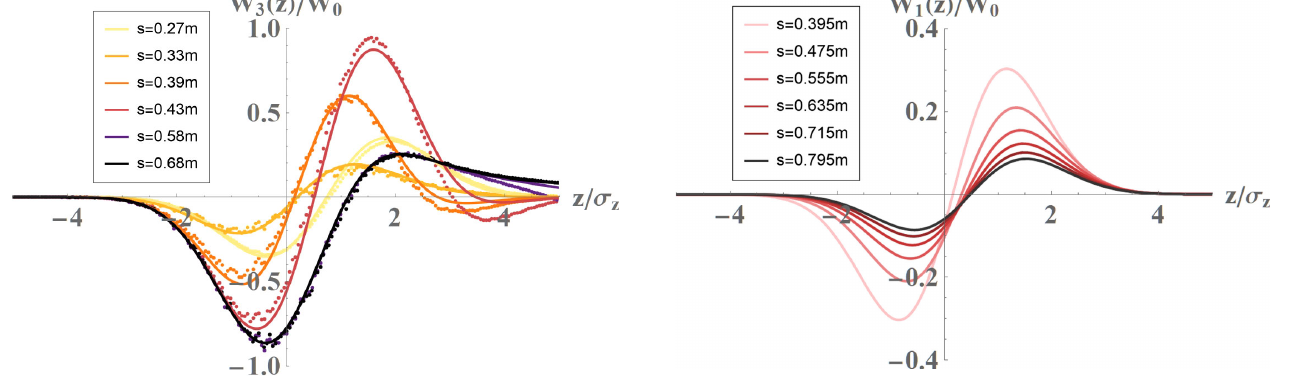
FIG. 17. Evolution of W 1 ð z Þ inside drift D2 in beamline D by theory prediction [See Eq. (106)]. The exit wake attenuates like as expected.